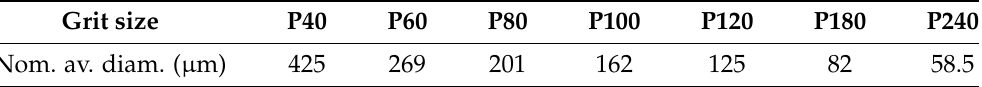
Table 1. Sandpaper grit size and the nominal average particle diameter in µ m [54]. Grit size P40 P60 P80 P100